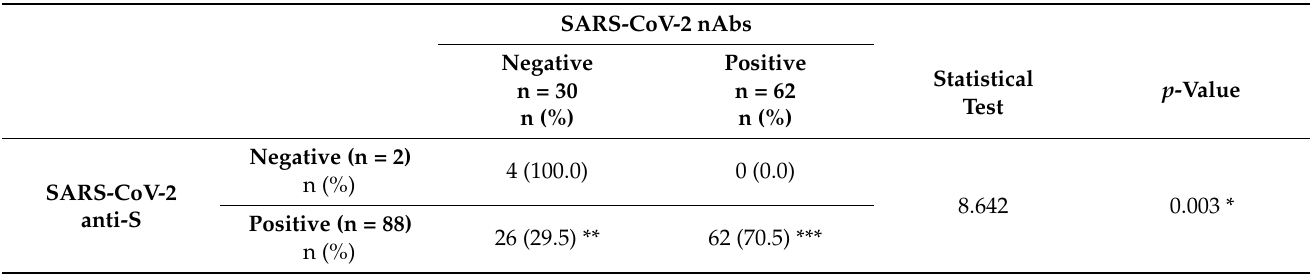
Table 2. Testing the association between the SARS-CoV-2 anti-S and nAbs among 92 Sinopharm vaccine recipients.